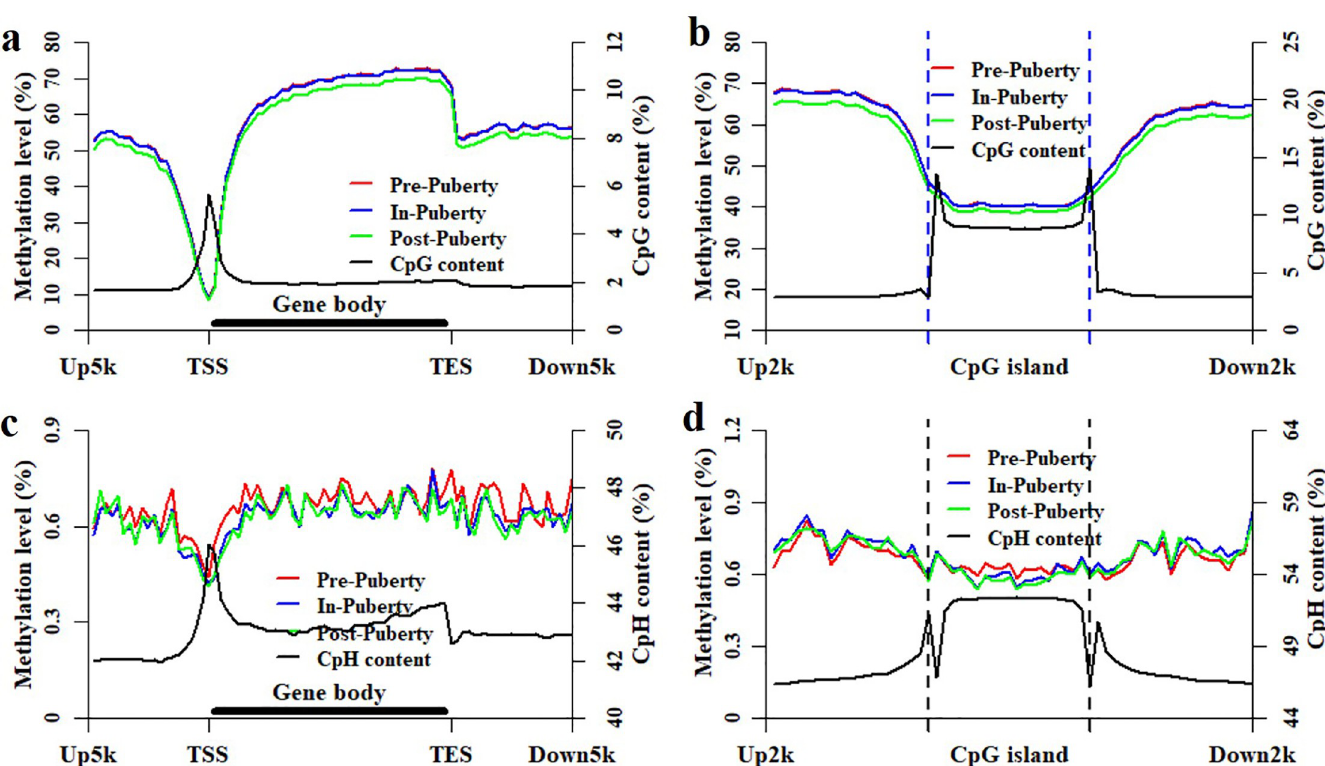
Fig 3. Methylation and density patterns of CpGs and CpHs at the locations of genes and CGIs. Methylation and density patterns of CpGs at the locations of genes ( a ) and CGIs ( b ). Methylation and density patterns of CpHs at the locations of genes ( c ) and CGIs ( d ).